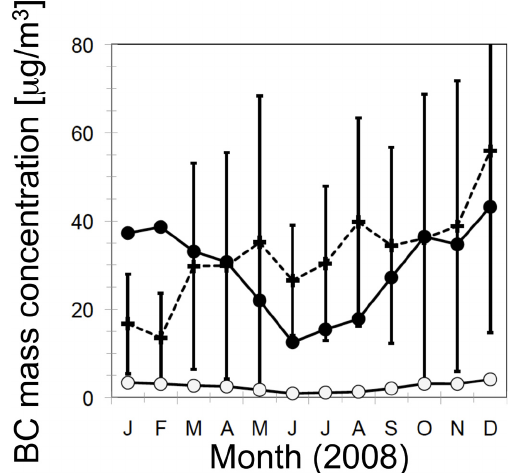
Fig. 2. BC mass concentration in Hyderabad for the year 2008. There are two simulations: SPRINTARS with the AeroCom emis- sions (solid line with white circles) and with the modified emissions by scaling a factor of 20 around Hyderabad (solid line with black circle) and skyradiometer measurements (dashed line with crosses).